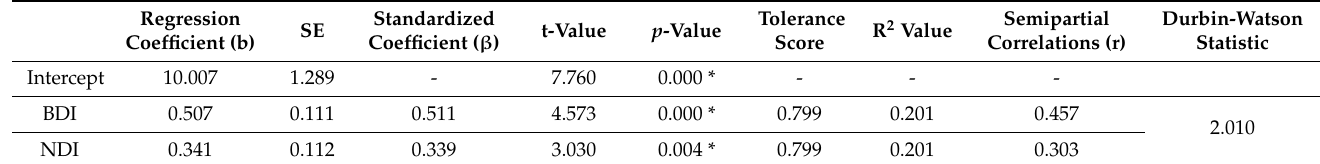
Table 7. Multiple linear regression model with the PSS − 10 as the dependent variable and BDI and NDI as independent variables.